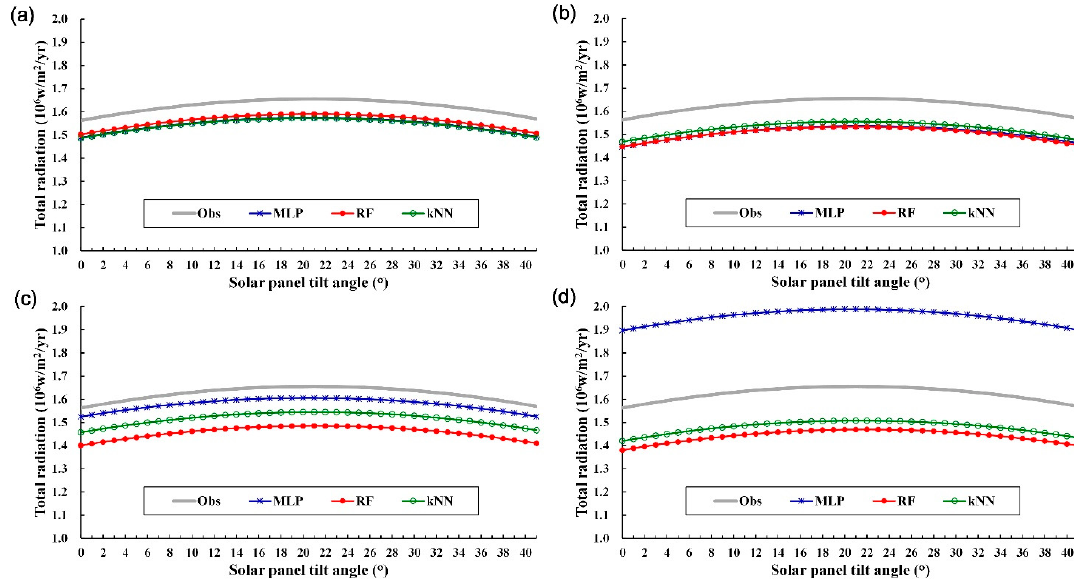
Figure 16. Observed and predicted values of the total annual global irradiance with a β ′ of 0–41° within ( a ) t + 1, ( b ) t + 3, ( c ) t + 6, and ( d ) t + 12.